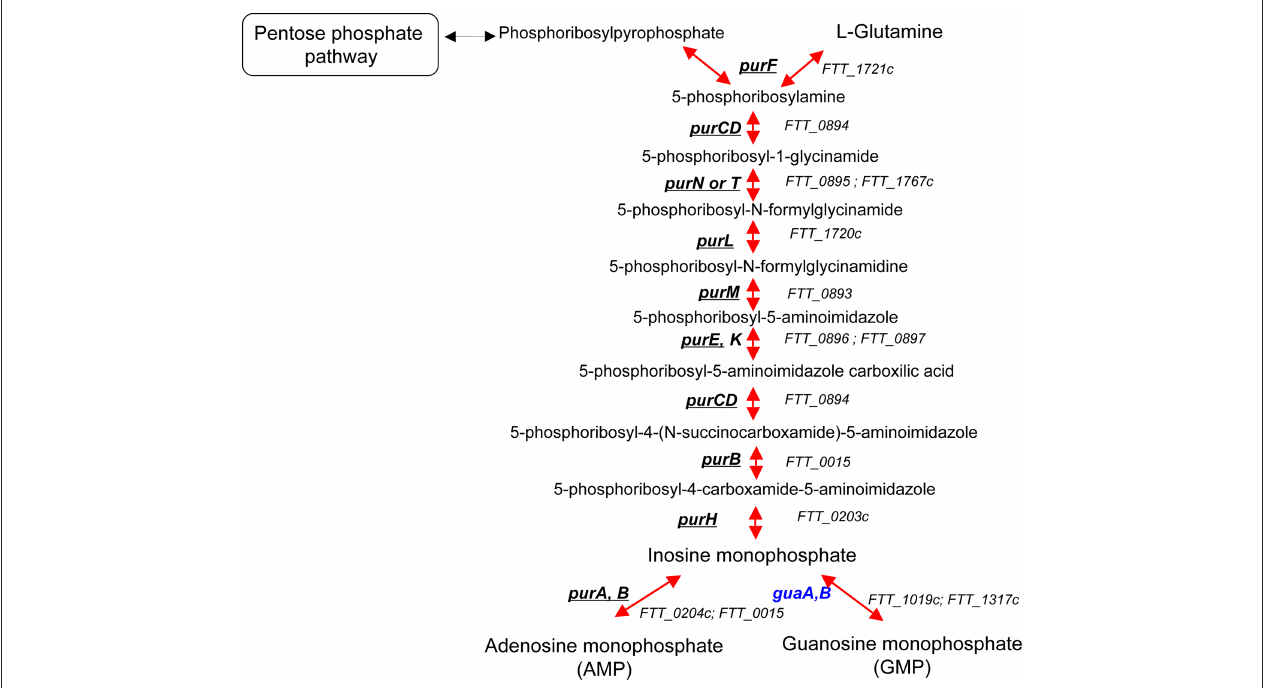
FiguRe 2 | The purine biosynthetic pathway. Genes that have been identified in genetic screens ( in vivo or in vitro ) are underlined. Genes that have not been hit in any screen are in